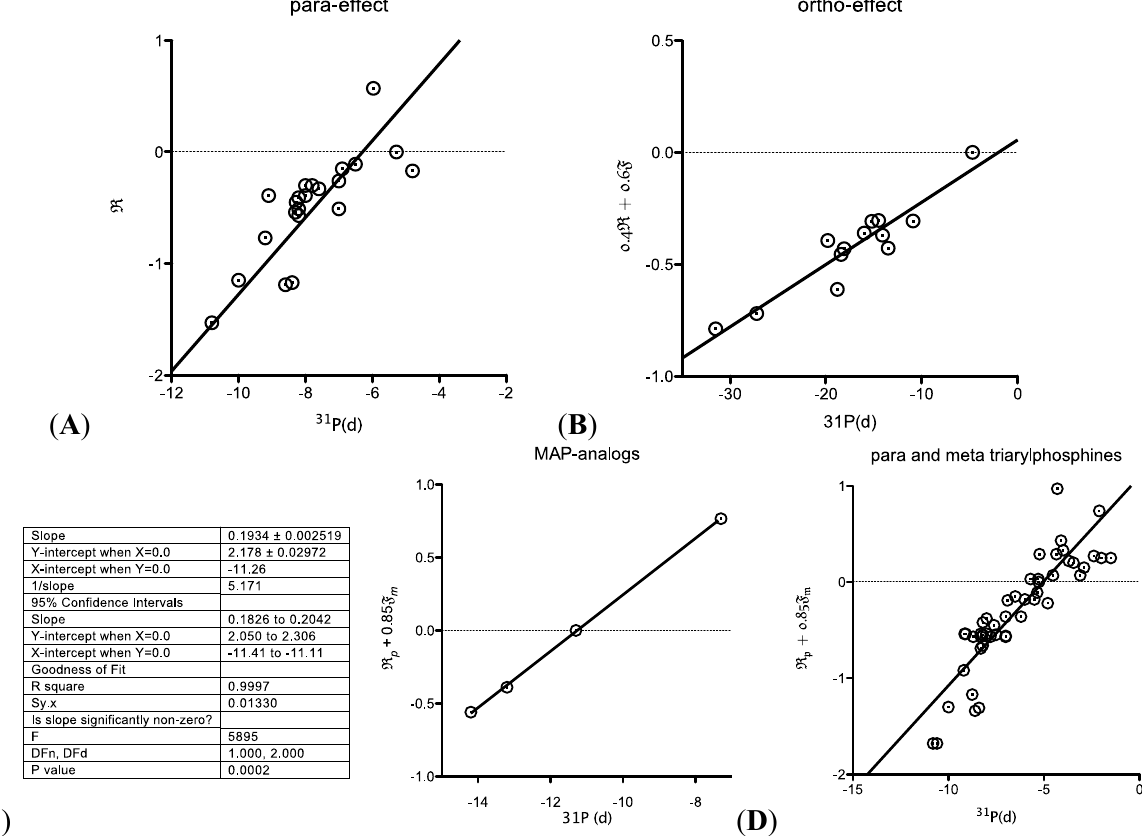
Figure 1. Correlation of 31 P chemical shifts with Swain and Lupton Resonance (R) and Field (F) parameters. ( A ) correlation of para-substituted triarylphosphines with R; ( B ) of ortho -substituted triarylphosphines with 0.4R + 0.6F; ( C ) the best correlation between the 31 P chemical shifts of 11a – d was obtained against the Swain and Lupton parameters + 0.85F ); ( D ) shows the correlation of para - and meta -substituted simple (R p m triarylphosphines against the same